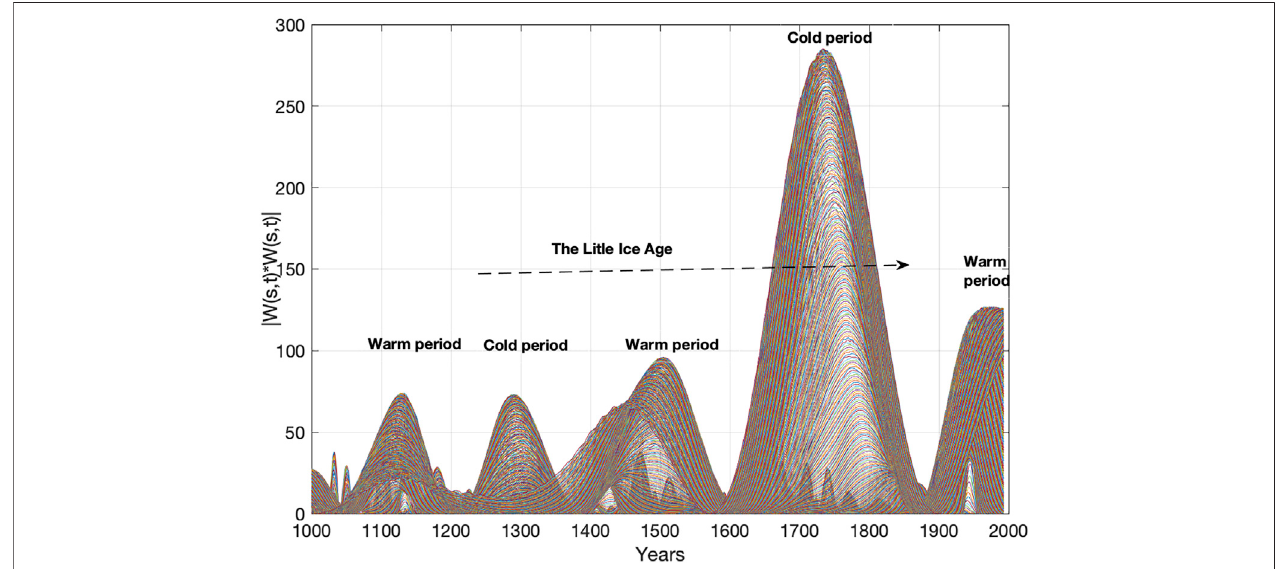
FIGURE 9 | Greenland ’ s GISP2 temperature wavelet power spectrum, WPgrt (s, t), for s = (1...500) and t = (1000 ... 1993) (yr.). The wavelet power spectrum shows dominant warm cycles and cold cycles from 1000 A.D., and the “ The Little Ice Age ” from approximately t = (1200 ... 1850) (yr.).